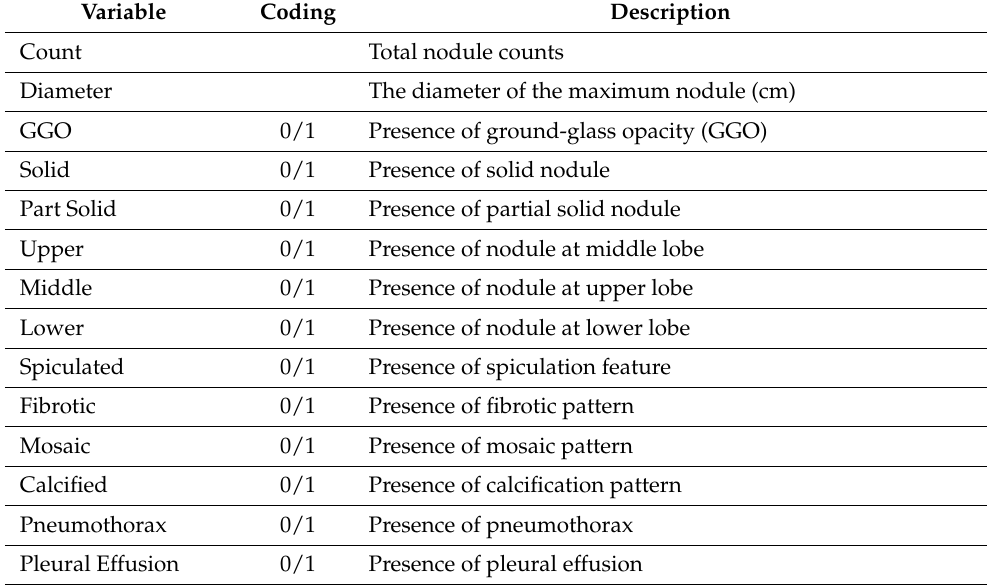
Table 2. The 14 investigated variables from LDCT text reports. Of these, 12 binary variables were coded as 0/1 for No/Yes to describe the presence of nodule pattern, location, and lung condition. The other two continuous variables were nodule count and